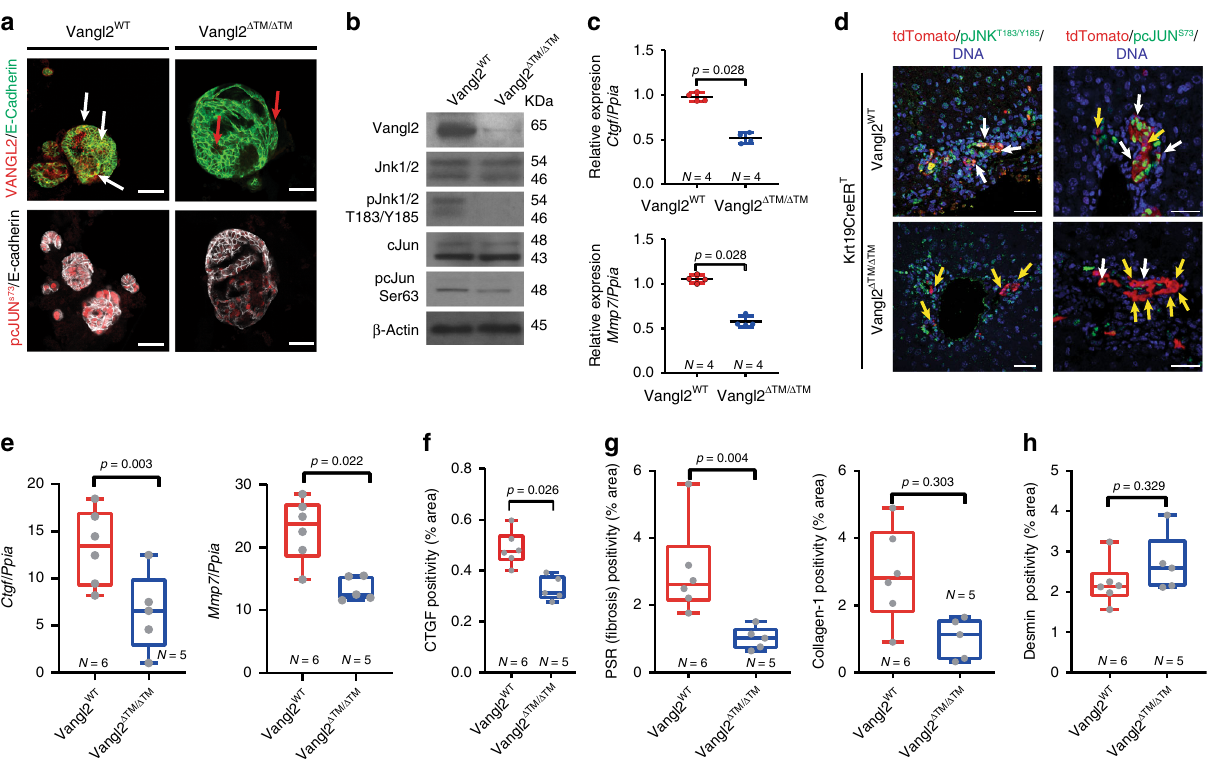
Fig. 6 Wnt-PCP loss alters Jnk-c-Jun signalling in biliary cells. a Biliary organoids from Vangl2 WT mice or Vangl2 fl ox mice (following treatment with Cre lentivirus, known as Vangl2 Δ TM ), immunostained for VANGL2 (red) membrane-bound E-cadherin (green), upper panels. White arrows denote co- immuno fl uorescence, whereas red arrows denote residual small Vangl2 puncta, not localised to the cell membrane. Lower panels represent the same conditions as described in ( a ), but stained for phosphorylated c-JUN S73 (red) and E-cadherin, white. b Western blot of proteins from Vangl2 WT and Vangl2 Δ TM biliary organoids. c Relative mRNA expression Wnt-PCP target genes, Ctgf and Mmp7 normalised to the housekeeping gene Ppia from Vangl2 WT and Vangl2 Δ TM biliary organoids. d Immuno fl uorescent staining of tdTomato (red), phosphorylated Jnk T183/Y185 or phosphorylated c-JUN S73 (green) and DNA (blue) in mice where Vangl2 has been deleted speci fi cally in biliary epithelial cell (Keratin-19-CreER T ::Vangl2 fl ox , following Cre activation known as Keratin-19-CreER T ::Vangl2 Δ TM ). White arrows denote dual-positive cells and yellow arrows denote cells that are only tdTomato (red) positive. e mRNA expression of Ctgf and Mmp7 normalised to the housekeeping gene Ppia in bile ducts isolated from Keratin-19-CreER T ::Vangl2 Δ TM mice following DDC injury. f Histological quanti fi cation of CTGF protein in Keratin-19-CreER T ::Vangl2 Δ TM mice following DDC-induced bile duct injury. g Histological quanti fi cation of total fi brillar collagen (Picrosirius Red, PSR), Collagen-1 and h Desmin ( fi broblasts) following DDC treatment of Keratin-19-CreER T :: Vangl2 Δ TM mice. Scale bar = 50 µ m. Source data are provided as a Source Data fi le. In all graphs, a Student ’ s t test is used. Box – whisker plots represent min – max range of the data. In dot plots, data are presented as mean ± S.E.M. Each data point (N) represents an individual animal. In ( c ), each N represents an experimental